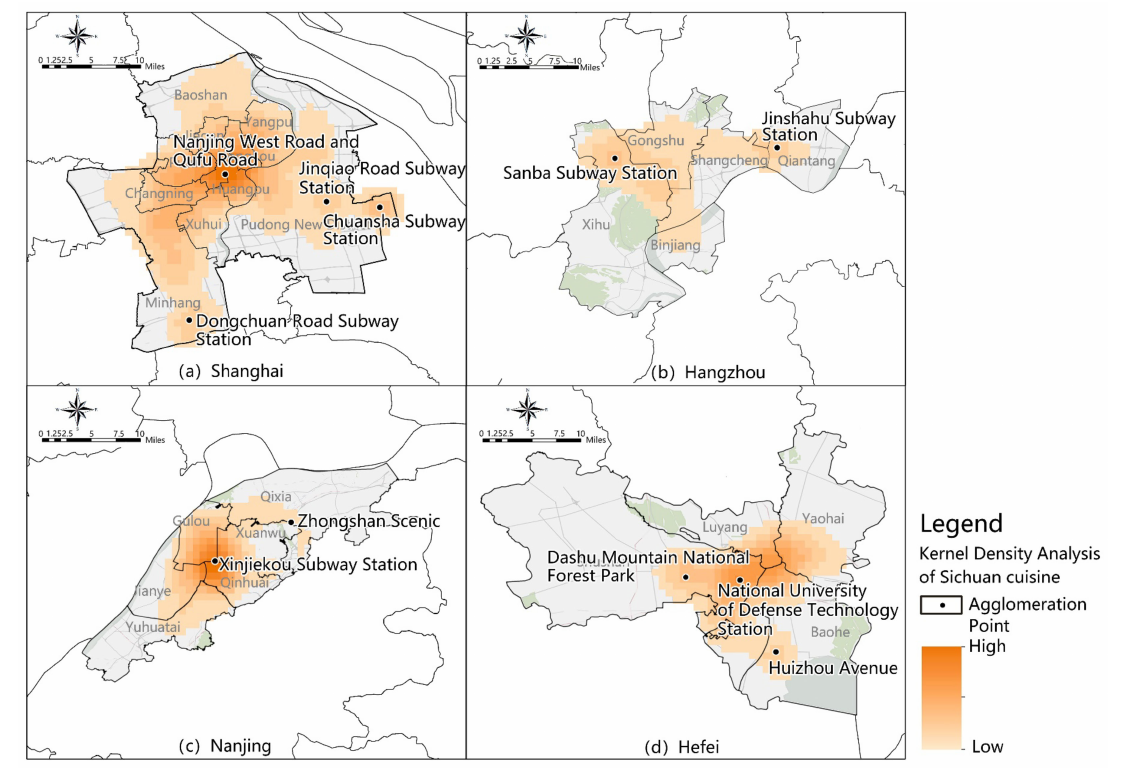
Figure 10. Kernel density analysis of Sichuan cuisine in the main urban areas of the four central cities in the YRD.